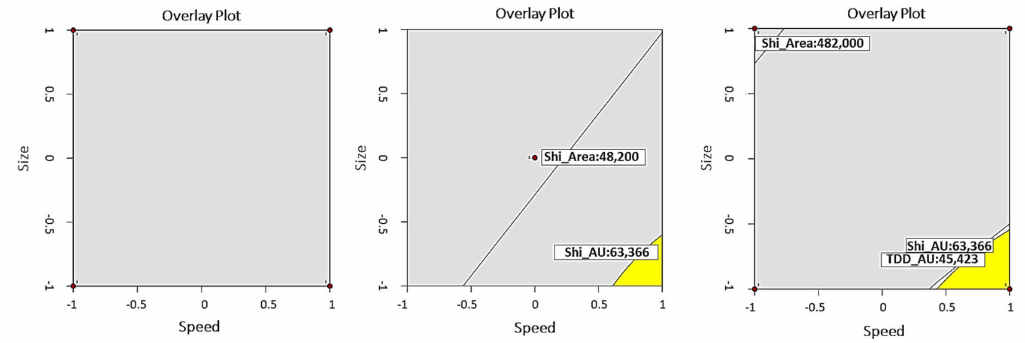
Figure 4. Contour plot with X1 (extraction temperature) fixed at –1, 0, + 1